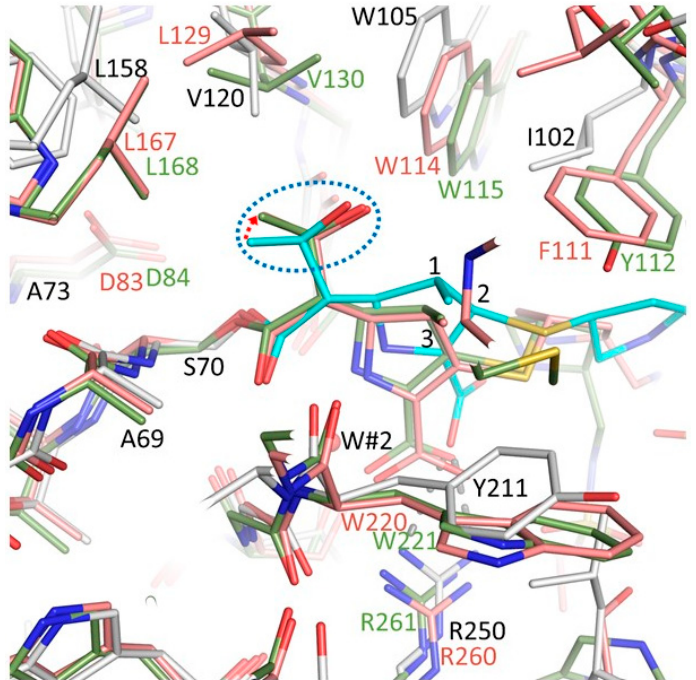
Figure 6. Superposition of the doripenem-bound structures of OXA-24 / 40 K84D, OXA-51 I129L / K83D, and OXA-48 K73A. Carbon atoms for the OXA-24 / 40 K84D doripenem complex are colored green; molecule A of OXA-48 K73A and OXA-51 I129L / K83D are colored as in Figure 5. The hydroxyethyl moiety of the doripenem’s pyrrolidine ring atom numbering and rotation are shown as in Figure 5. The superpositioning involved the same set of 25 C α atoms as in Figure 5 onto their equivalent residues in the OXA-24 / 40 K84D complex. Except for S70 and A71, all residues of their respective OXAs are labeled and